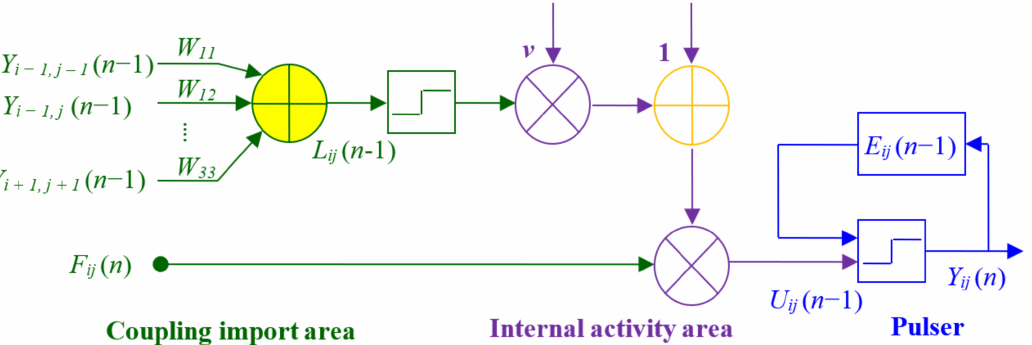
Figure A1. Model of PCNN. The green part refers to the coupling import area, the purple one refers to the internal activity area, and the blue one refers to the